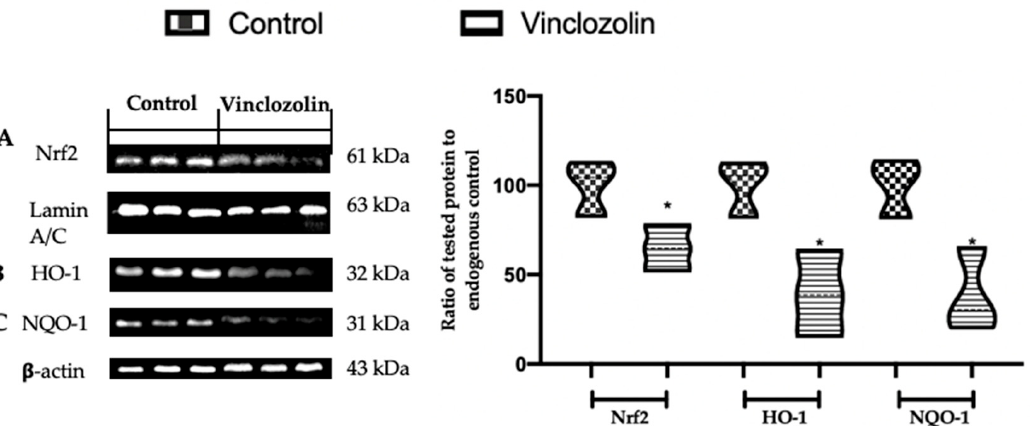
Figure 8. Effects of vinclozolin exposure on the oxidative stress response: Western blot analysis of